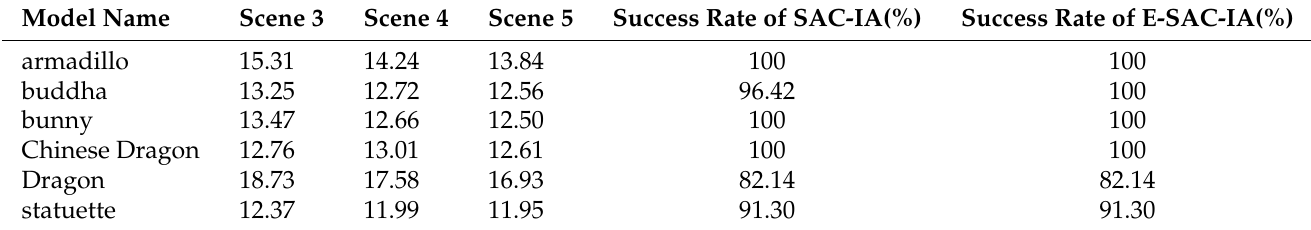
Table 4. Efficiency and success ratio of the E-SAC-IA to original SAC-IA